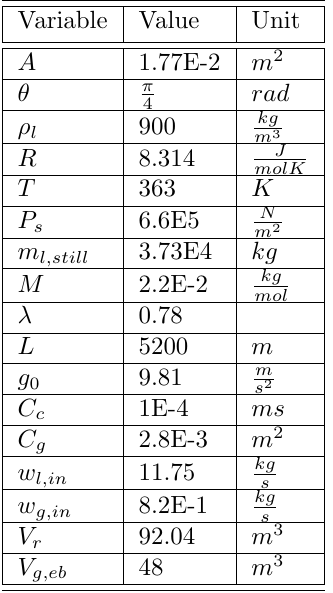
Table 6: Parameters for the Di Meglio model Eqs.